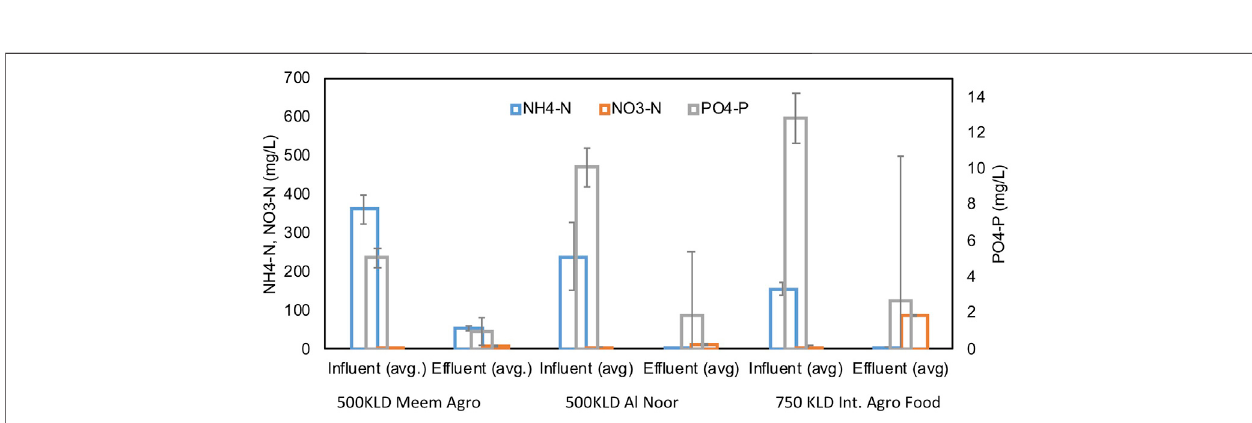
Frontiers in Environmental Science |